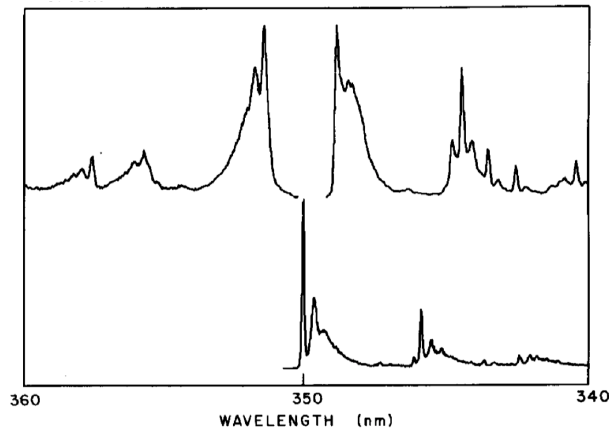
Figure 8. The upper trace left is the beginning of the fluorescence spectrum; the upper trace right is the beginning of the one ‐ photon fluorescence excitation spectrum; the lower trace is the beginning of the two ‐ photon fluorescence excitation spectrum. The two traces on the right are the same as the extreme left of Figure 7. [59,67,68].